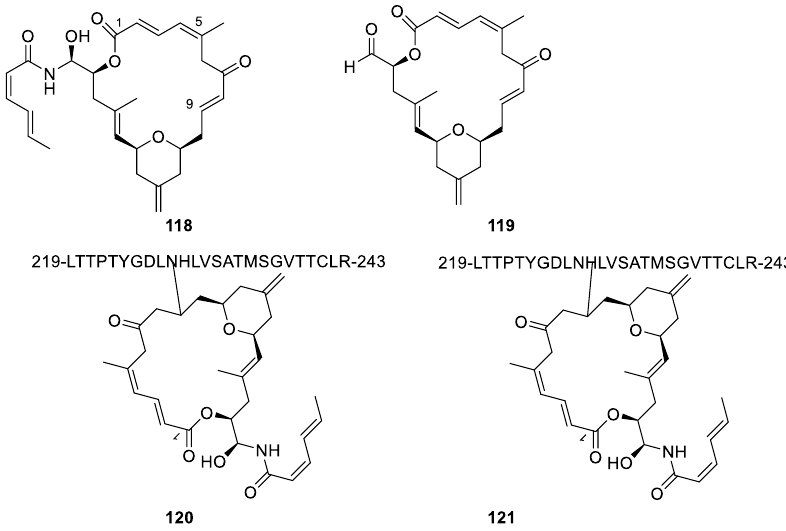
Figure 32. Zampanolide ( 118 ) and dactyloide ( 119 ) and suggested products ( 120 and 121 ) formed by reacting microtubule with zampanolide [107,108] . reacting microtubule with zampanolide